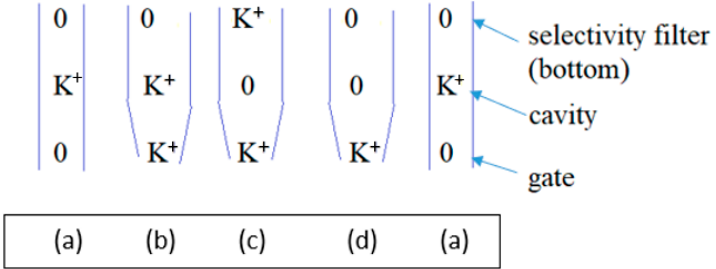
Figure 8. Cycle of states at the oscillating gate. In going from (a) to (b), the gate oscillates to hold the ion, which must remain until the ion in the cavity (which does show in the X-ray structure) moves up to the selectivity filter (top position, (c)). This ion can then move up further within the selectivity filter (d), leaving space for the ion at the gate to move into the cavity, returning to state (a), where the gate can again relax, in preparation for the next ion. Based on calculations, the contraction part of the gate oscillation cycle appears to be an increased density of water at the gate, rather than a change in protein conformation or gate diameter. Adapted from ref.